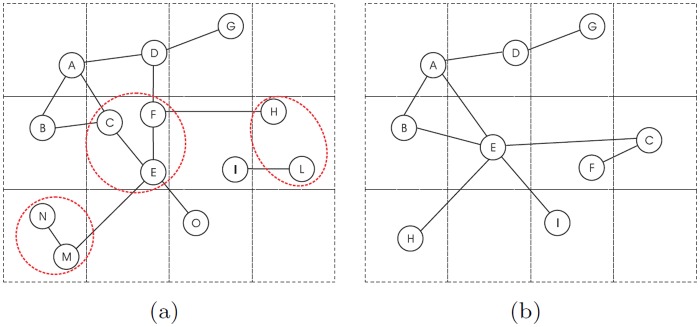
One-step abstraction process.One-step application of the abstraction process to a small graph. (a) Original graph G. Red (dashed) circles identify the group of nodes that will be merged together. (b) Output graph G
i in which nodes c, f, e, h, l and n, m are collapsed into new nodes e, c, h ∈ V
i respectively. Coordinates are the barycenter of collapsed nodes. Three edges are then removed because they connect the collapsed nodes: (n, m), (c, e), and (f, e).